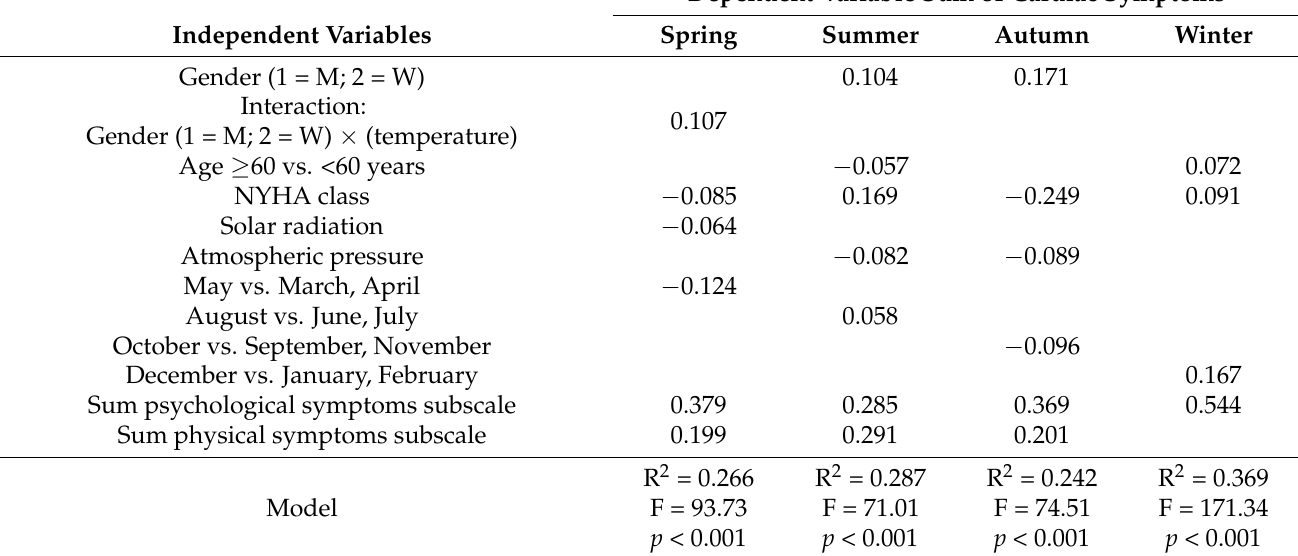
Table 4. Multiple linear regression analysis predicting the reporting cardiac symptoms scores sepa- rately by four seasons (significant standardized regression coefficients β